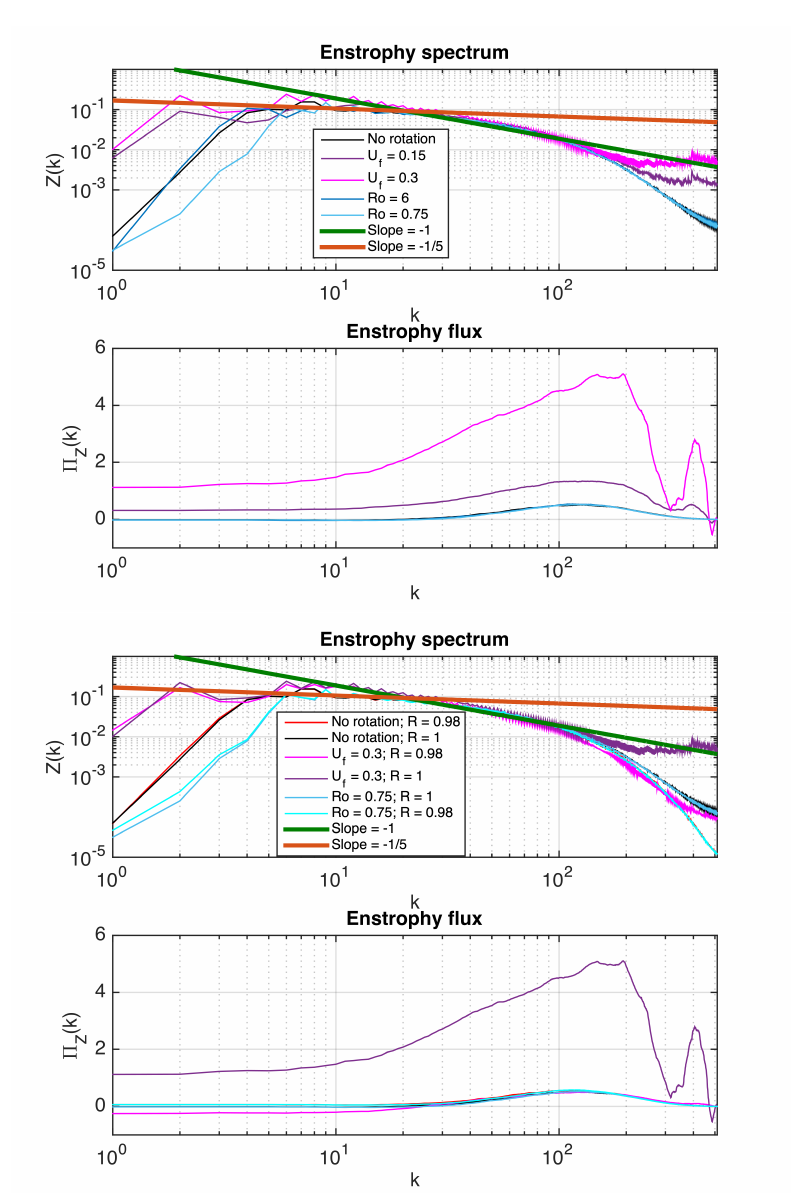
Figure 15. First and second rows: Enstrophy spectra and fluxes for strong, moderate and no rotation for methods 1 and 2. Third and fourth rows: Tukey windowed enstrophy spectra and fluxes for strong rotations. Method 1 Ro = 0.75. Method 2 U f = 0.3. Radius of the window R =